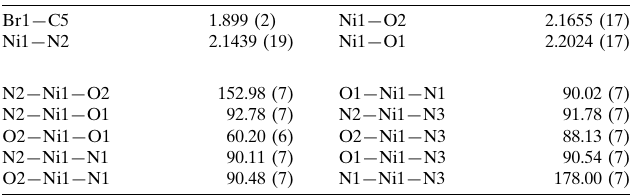
Selected geometric parameters (A˚ , (cid:1)